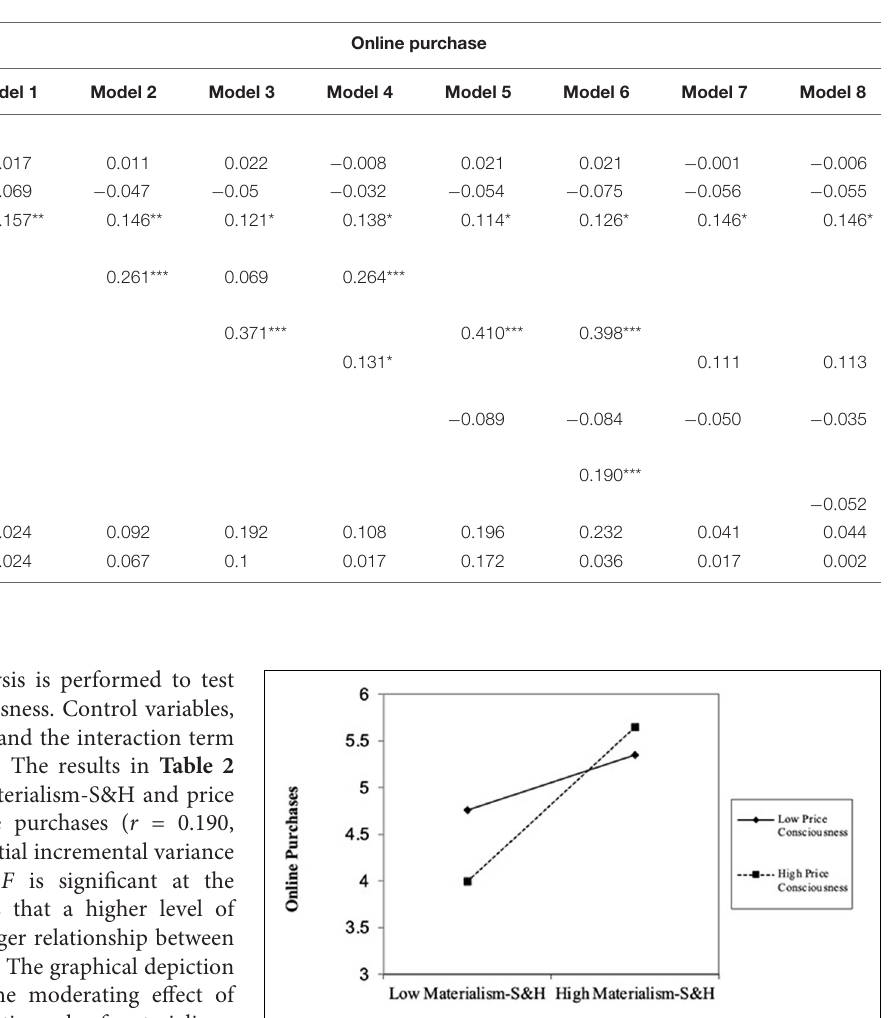
TABLE 2 | Results of the regression analyses.